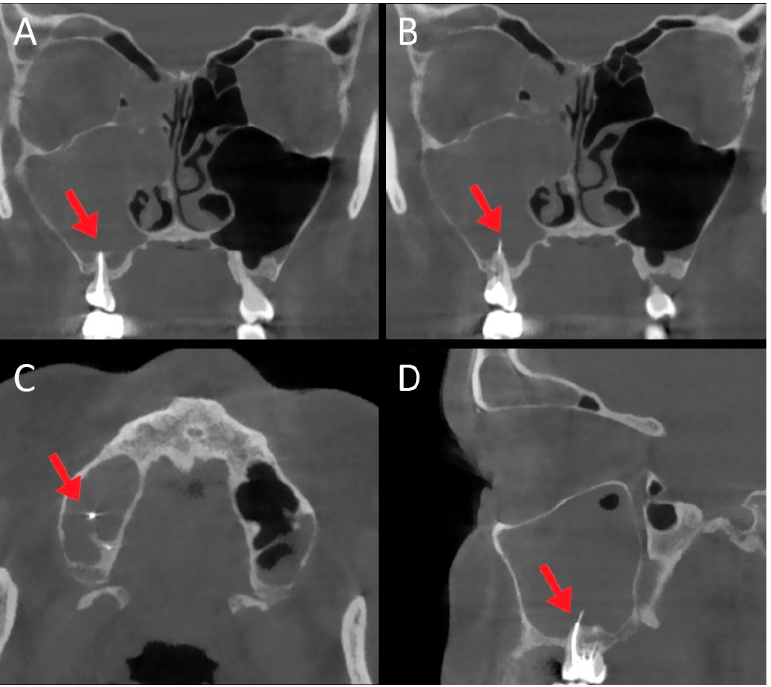
Figure 2. Female patient, 52 years old, complaining of facial pain, nasal obstruction, and rhinorrhea with a history of endodontic treatment 5 months earlier. CT (( A , B ): coronal scan; ( C ): axial scan; ( D ): sagittal scan) revealed chronic right maxillary sinusitis extending to the right frontal sinus, and the presence of endodontic material in the right maxillary sinus (red arrows). Endoscopic surgery was performed before subsequent revision of dental surgery.